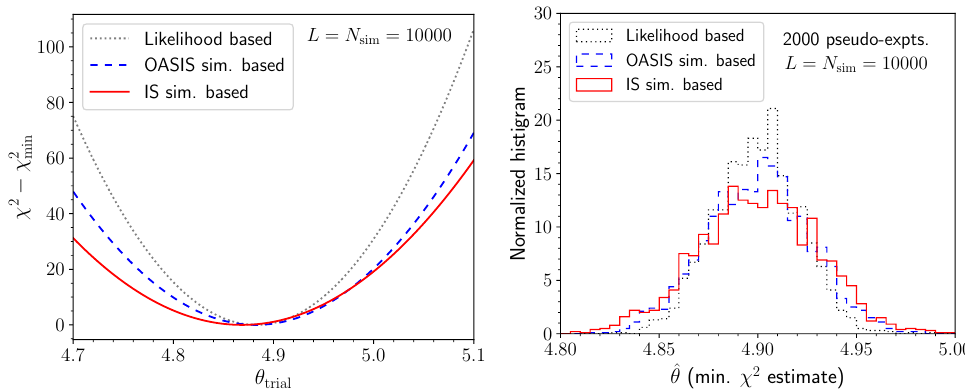
Figure 5: The left panel illustrates the minimum χ 2 estimation of θ in one typical true pseudo-experiment using a) the theoretical knowledge of the analytical form of (38) in order to construct the likelihood function (gray dotted line); b) simulation using OASIS-trained sampling distribution (blue dashed line); and c) simulation using IS sampling distribution (red solid line). The integrated luminosity L for the real data, and the number of simulated events N were both set to 10,000 (corresponding to s = 4.9. The events were roughly equal number of real and simulated events), and θ true re-weighted for different θ values as in [ 51,52 ] . Higher convexity is indicative of trial lower error bars on the estimate ˆ θ . The right panel shows the distribution of ˆ θ for the same three methods of θ estimation across 2000 pseudo-experiments, each with different instances of real and simulated